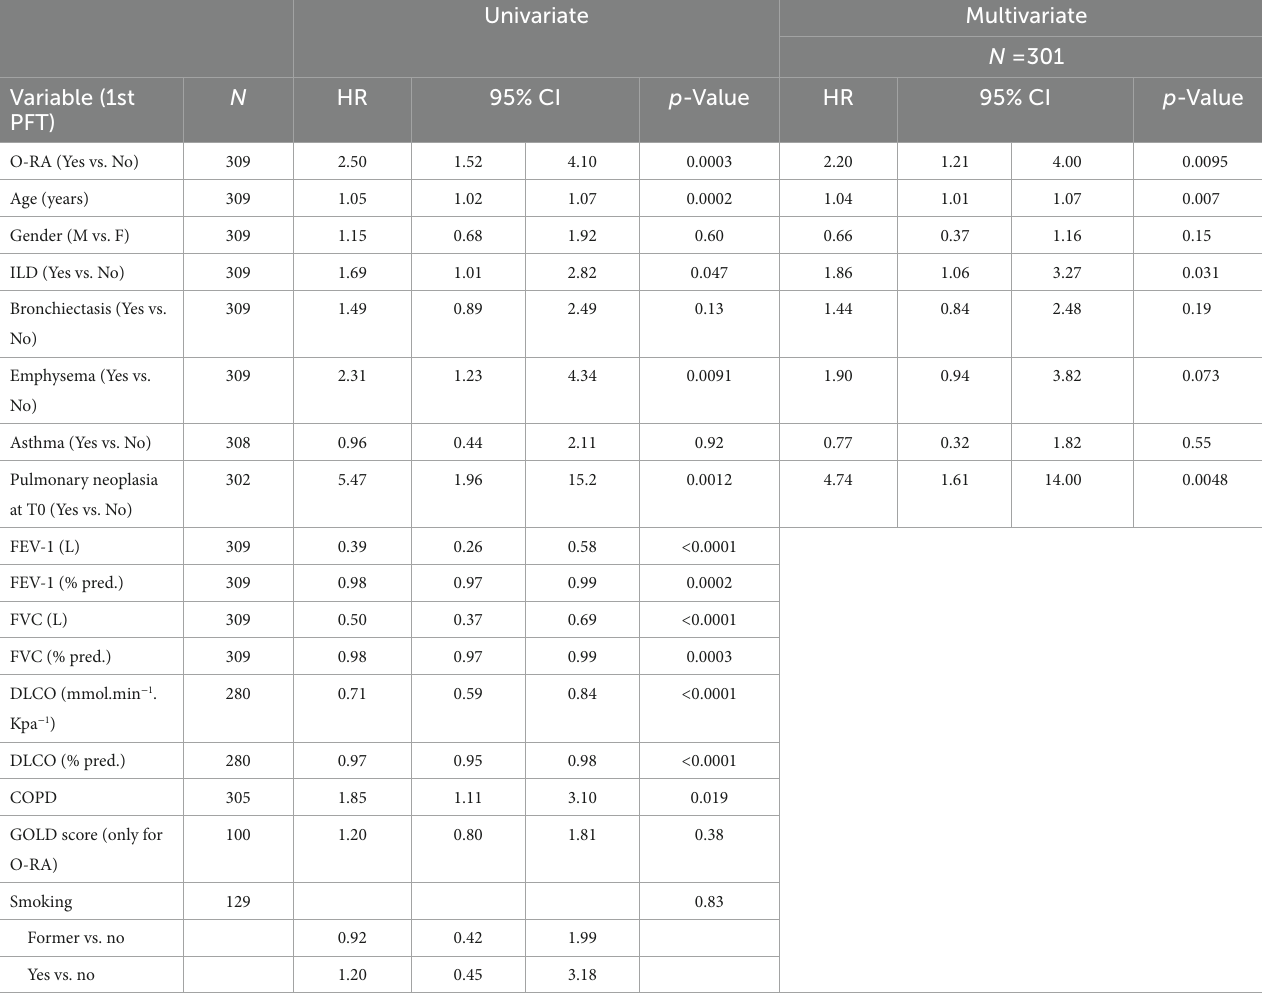
TABLE 4 Multivariate cox regression analysis.